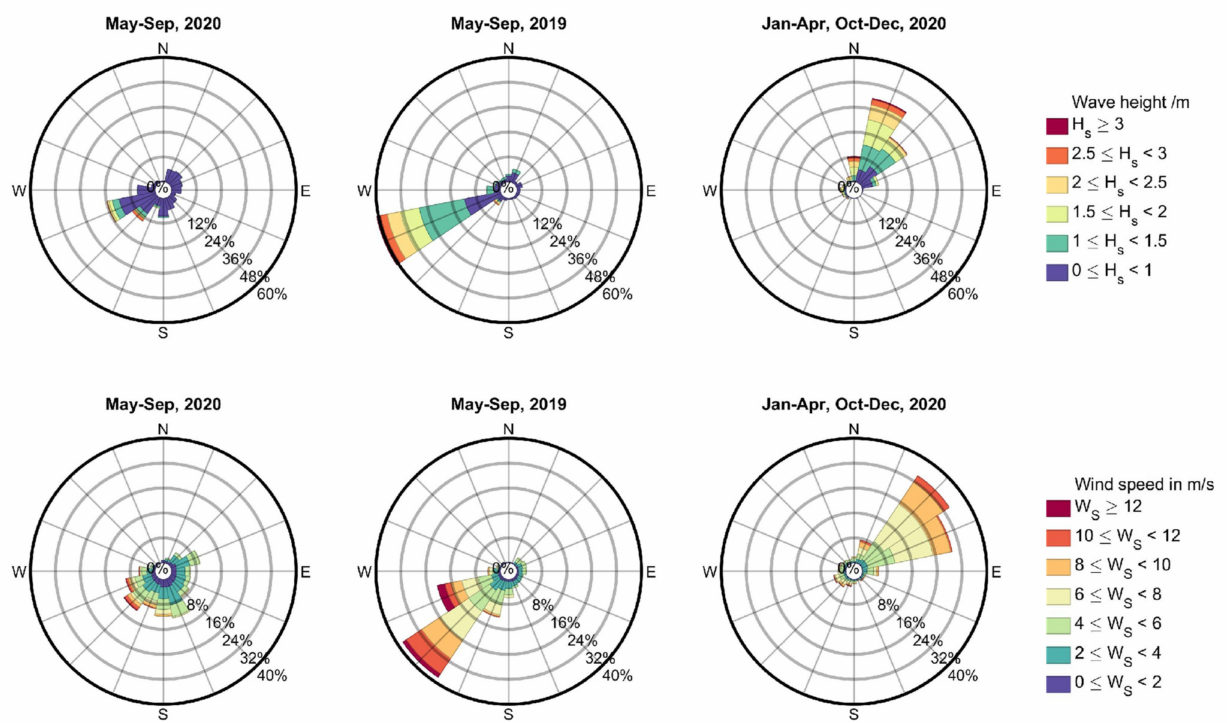
Figure 4. Comparison of the rose plot of SWH ( upper panel) and wind speed ( lower panel) between different periods at buoy A station based on ERA5